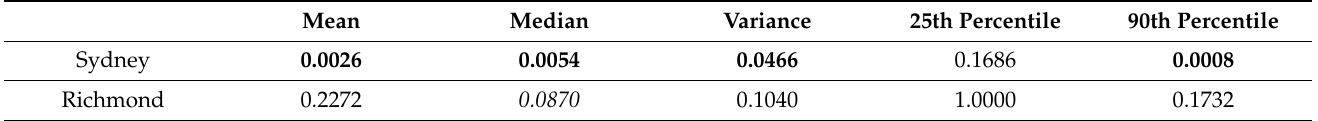
Table 2. p -values for difference in mean, median, variance, 25th percentile, and 95th percentile for entire summer months combined. Significant p -values < 0.05 are in bold, and those just above or < 0.10 are in bold italics. Tests were conducted using 5000